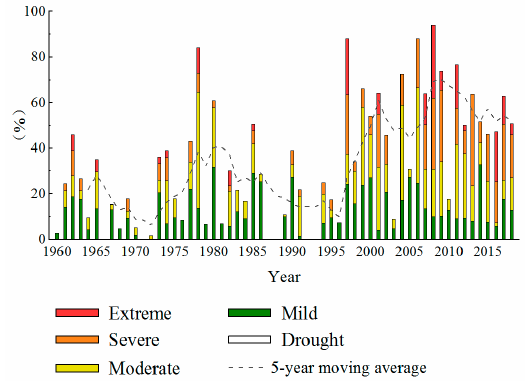
Figure 5. The changes of arid area ratio over the years.